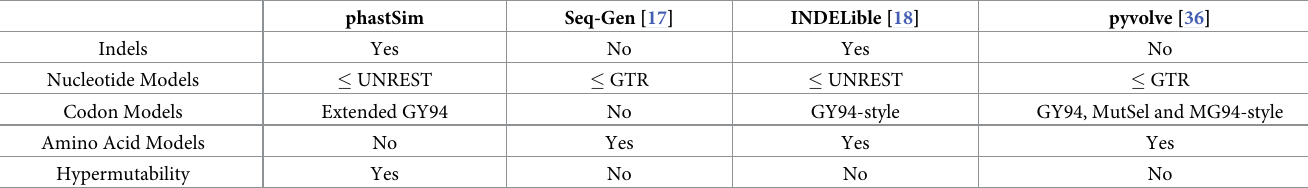
Table 2. A comparison of features of different sequence evolution simulation software packages.